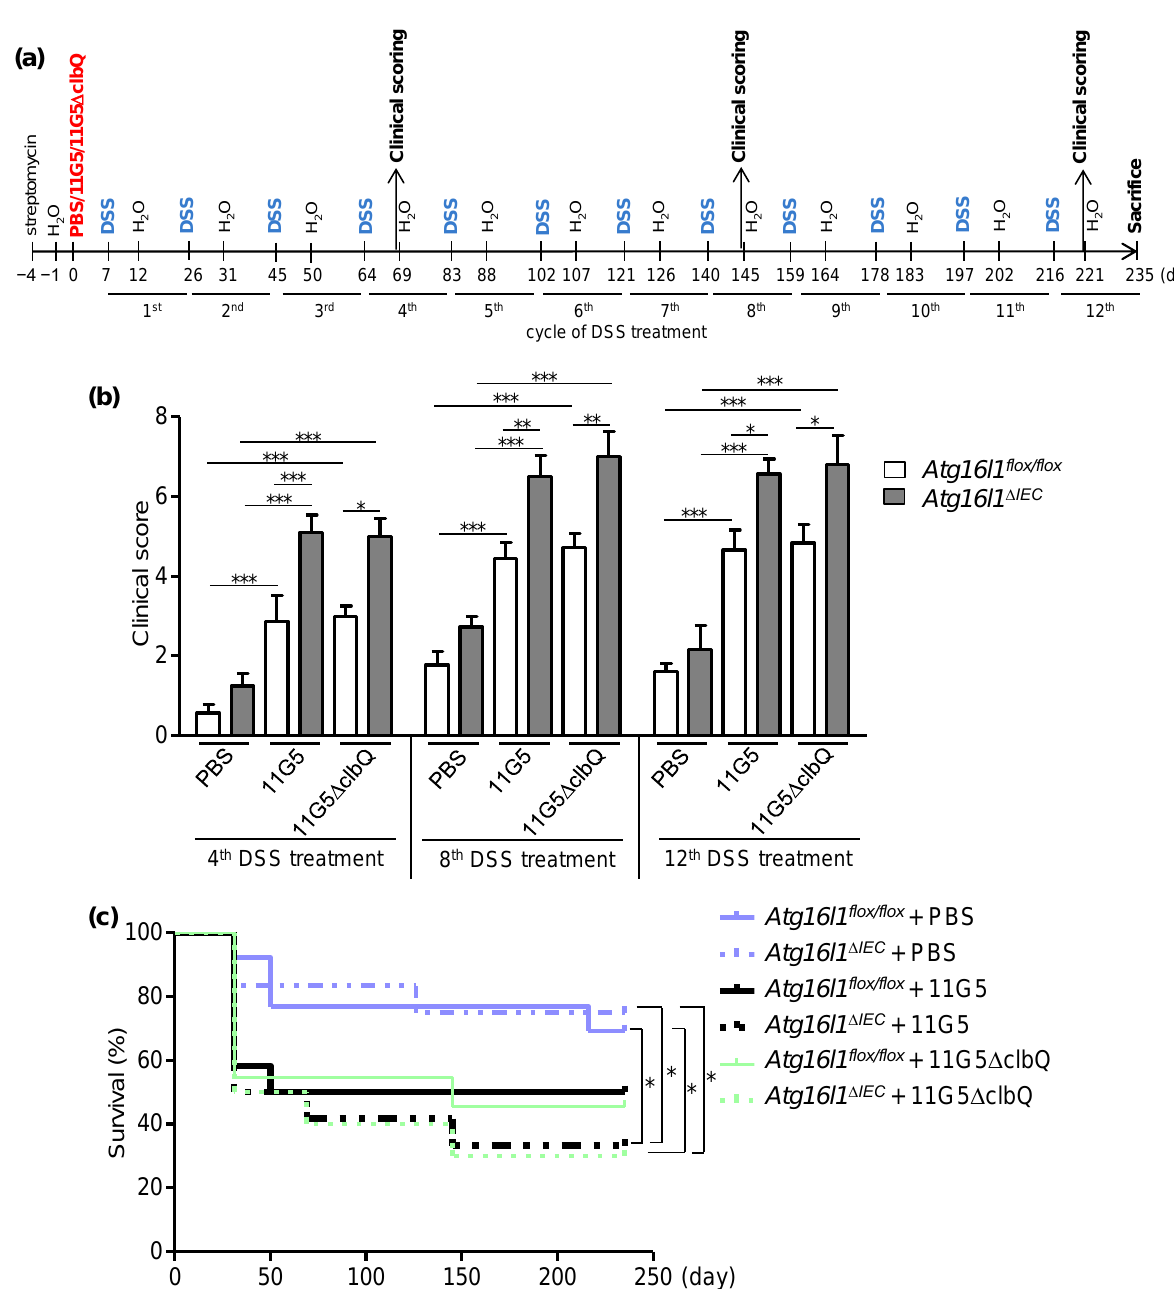
Figure 1. CoPEC infection increases the susceptibility of mice to the chronic DSS treatment independently of colibactin, and this is further enhanced by autophagy deficiency in IECs. ( a ) In vivo infection protocol. Atg16l1 flox/flox and Atg16l1 ∆ IEC mice were treated with streptomycin for 3 days and then received water for 24 h before being orally administered (day 0) with PBS or with 10 9 colony-forming units of 11G5 bacteria or the mutant 11G5 ∆ clbQ. Seven days later, the mice were subjected to 12 cycles of DSS treatment, with each cycle consisted of 1% of DSS in drinking water for 5 days followed by 14-day of regular water. ( b ) Clinical activity score was determined based on the assessment of body weight loss, stool consistency, and the presence of occult blood in the stool after the 4th, 8th and 12th DSS treatment (after 5 days of treatment, just before the mice were given regular water). Results are means ± SEM. N = 10 mice/group for + PBS and 11G5-infected conditions; N = 6 mice/group for 11G5 ∆ clbQ-infected condition. ( c ) Survival of mice during the chronic DSS treatment. Atg16l1 flox/flox + PBS: N = 13; Atg16l1 ∆ IEC + PBS: N = 12; Atg16l1 flox/flox + 11G5: N = 12; Atg16l1 ∆ IEC + 11G5: N = 12; Atg16l1 flox/flox + 11G5 ∆ clbQ: N = 11; Atg16l1 ∆ IEC + 11G5 ∆ clbQ: N = 10. * p < 0.05; ** p ≤ 0.01; *** p ≤ 0.001 by one-way Anova, followed by a post-test Bonferroni in ( b ) and Gehan-Breslow-Wilcoxon test in ( c ). Under 11G5 or 11G5∆clbQ infection, Atg16l1 flox/flox or Atg16l1 ∆IEC mice displayed a higher susceptibility to DSS treatment, compared to uninfected mice (or + PBS groups, i.e.,